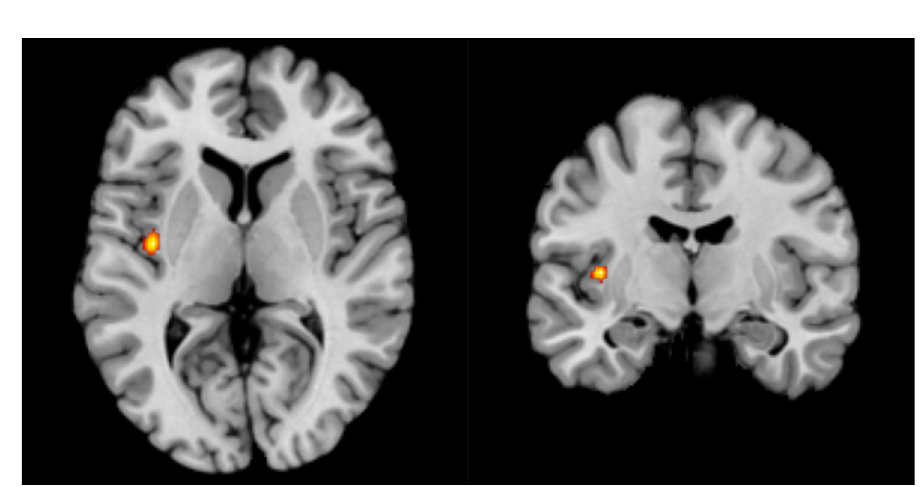
Figure 1. Axial and coronal view displaying the cluster of increased activity in unipolar depression compared to bipolar depression. Red to yellow: significant meta-analytic results (p <